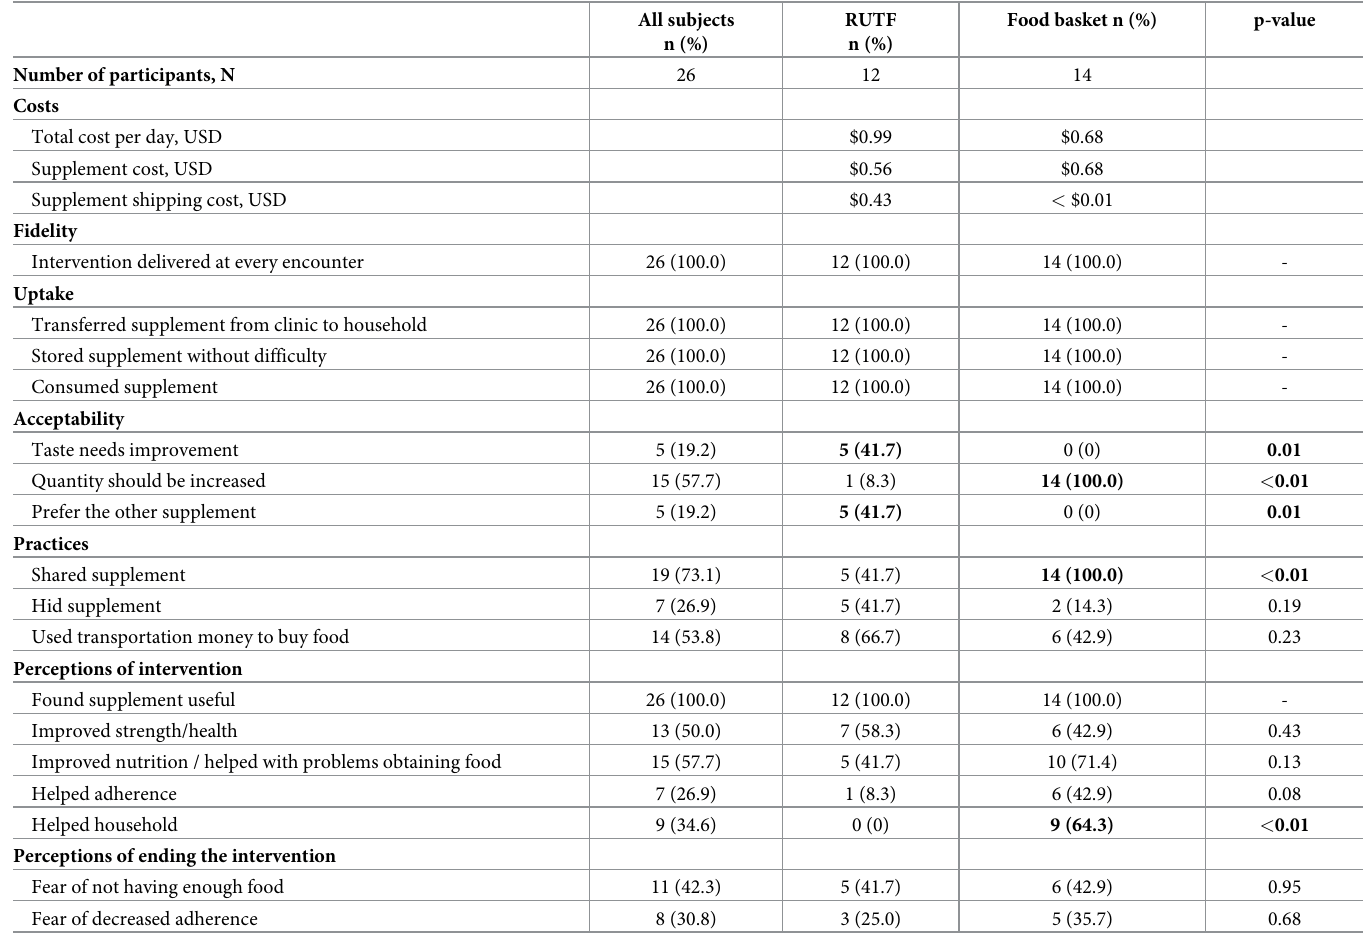
Table 2. Implementation outcomes, practices, and perceptions of RUTF versus the food